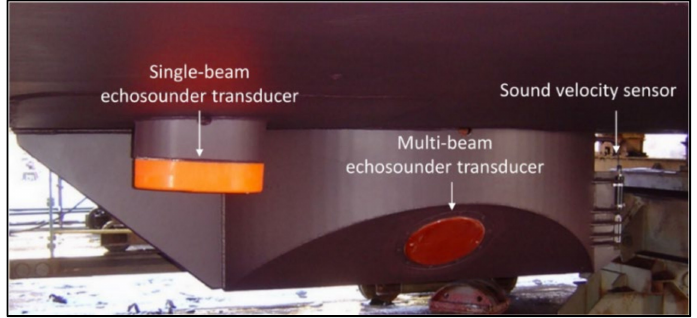
Figure 10. Under-keel blister with multibeam, single-beam transducers, and sound velocity